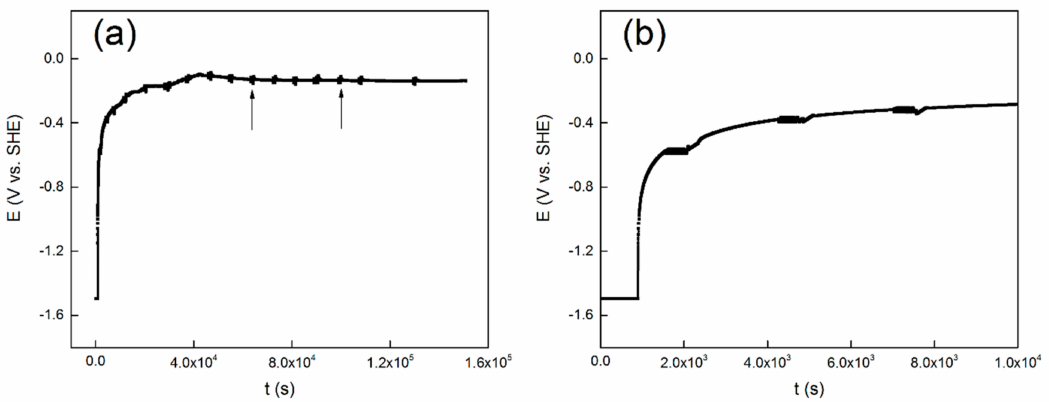
Figure 1. Evolution of open circuit potential with time for the TC11 alloy in 0.01 M Na 2 SO 4 solution, ( a ) the total 36 h, and ( b ) the first 10